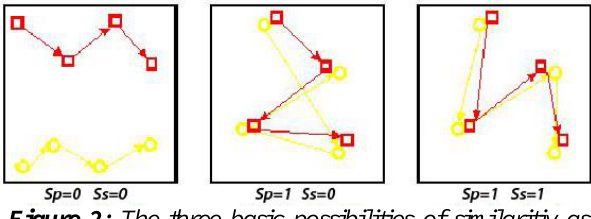
Figure 2 : The three basic possibilities of similaritiy as given by Sp and Ss.